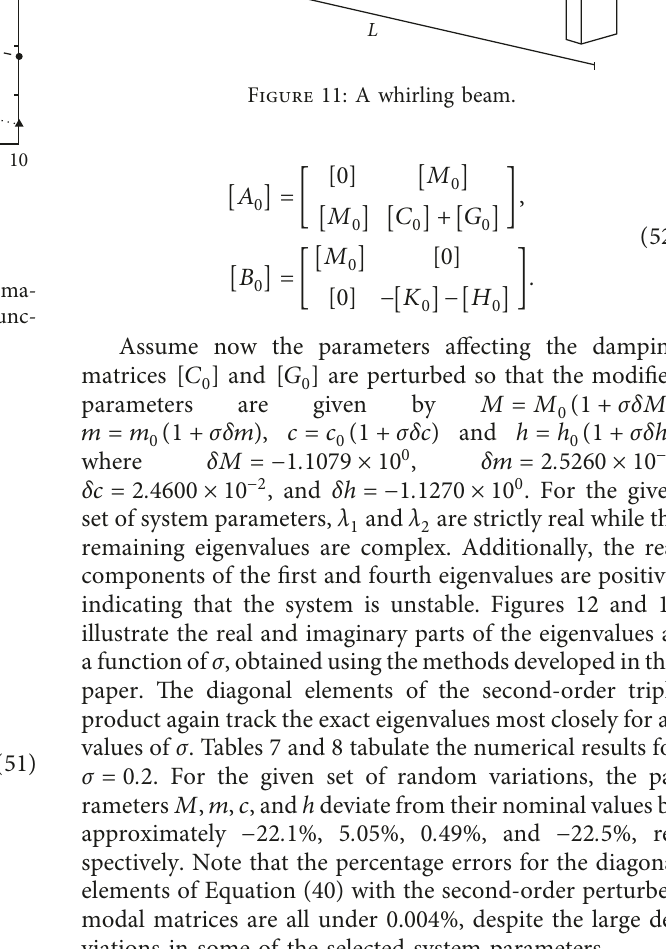
Figure 11: A whirling